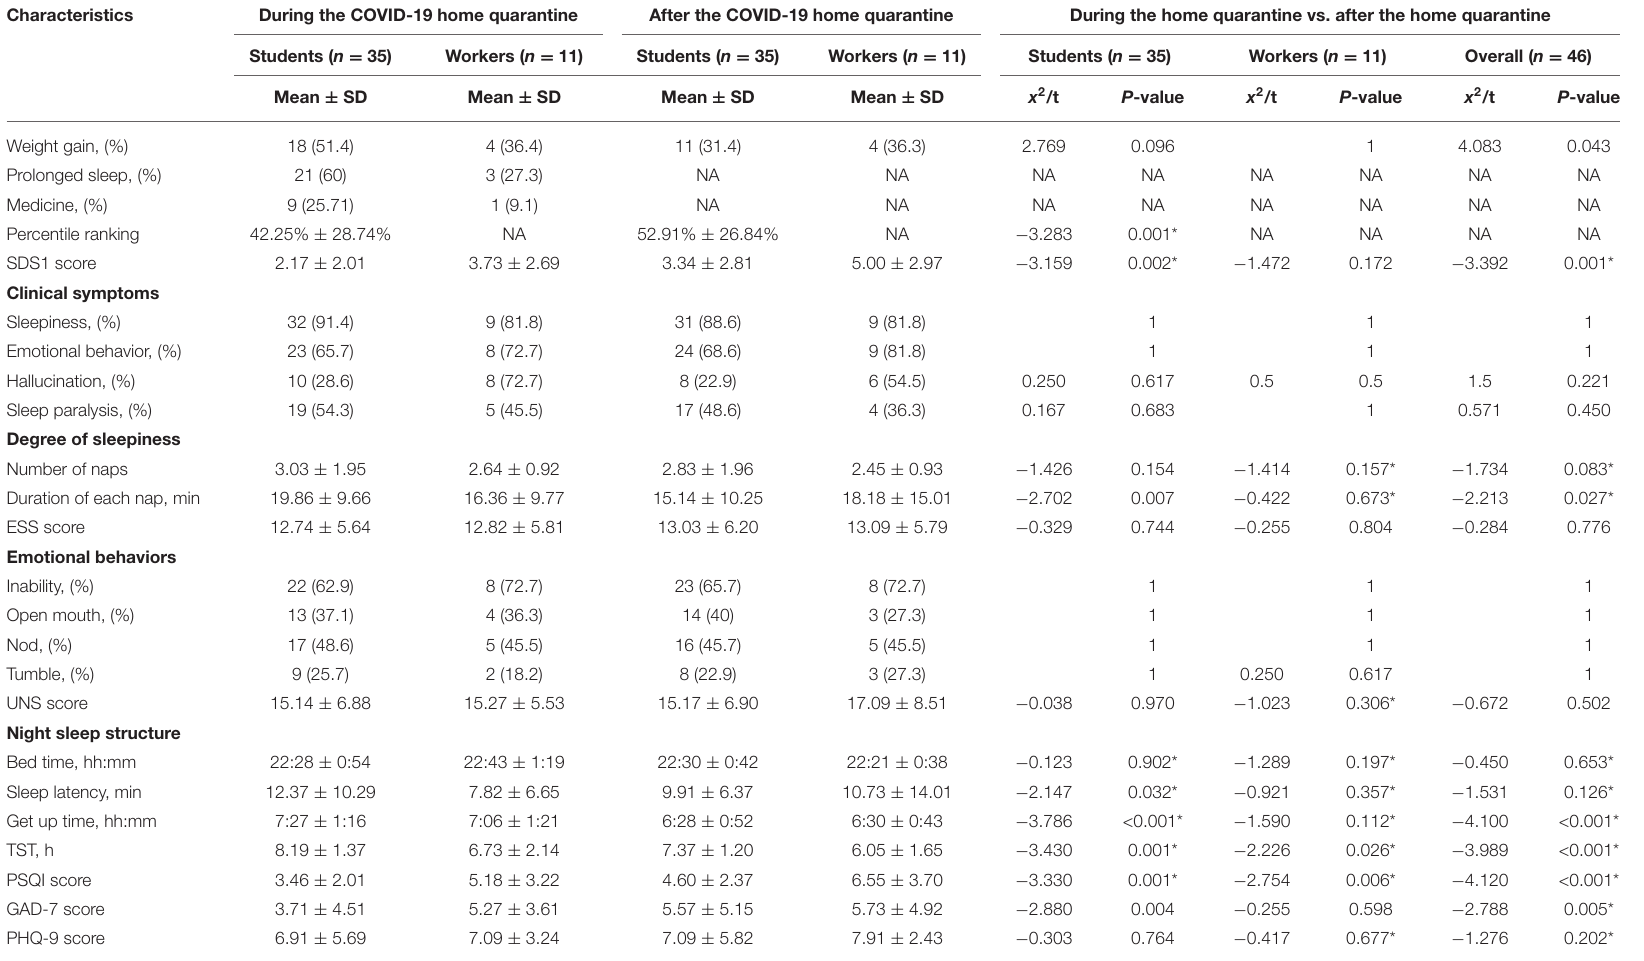
TABLE 2 | The sleep pattern and school performance were affected by the COVID-19 home quarantine in narcolepsy patients.